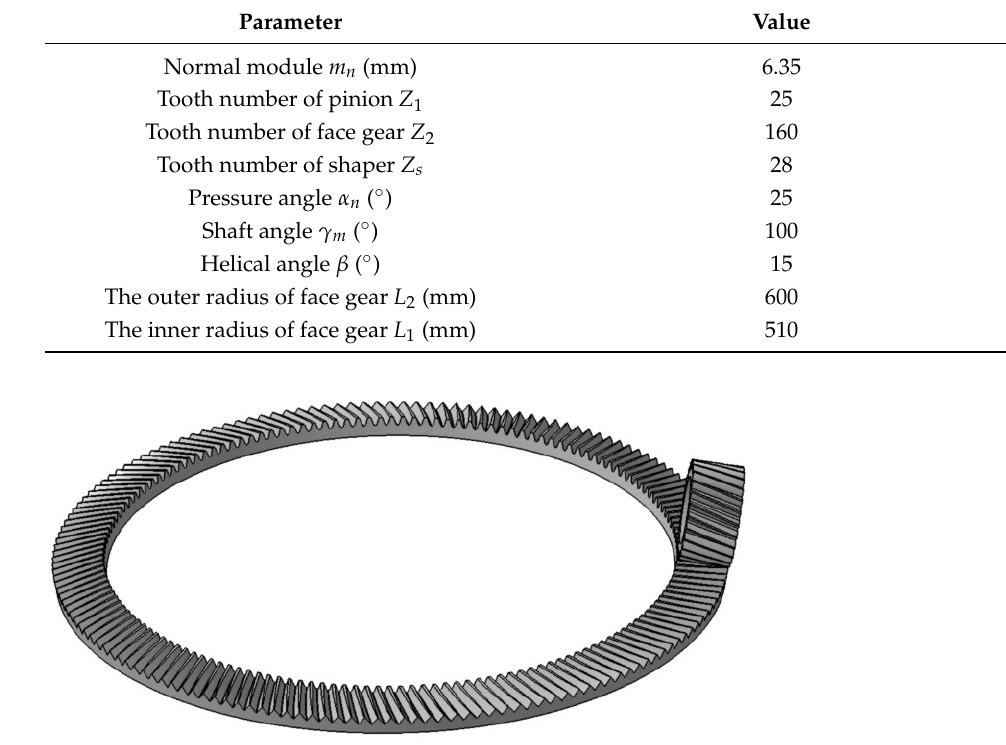
Table 1. Basic design parameters of a helical face gear drive.